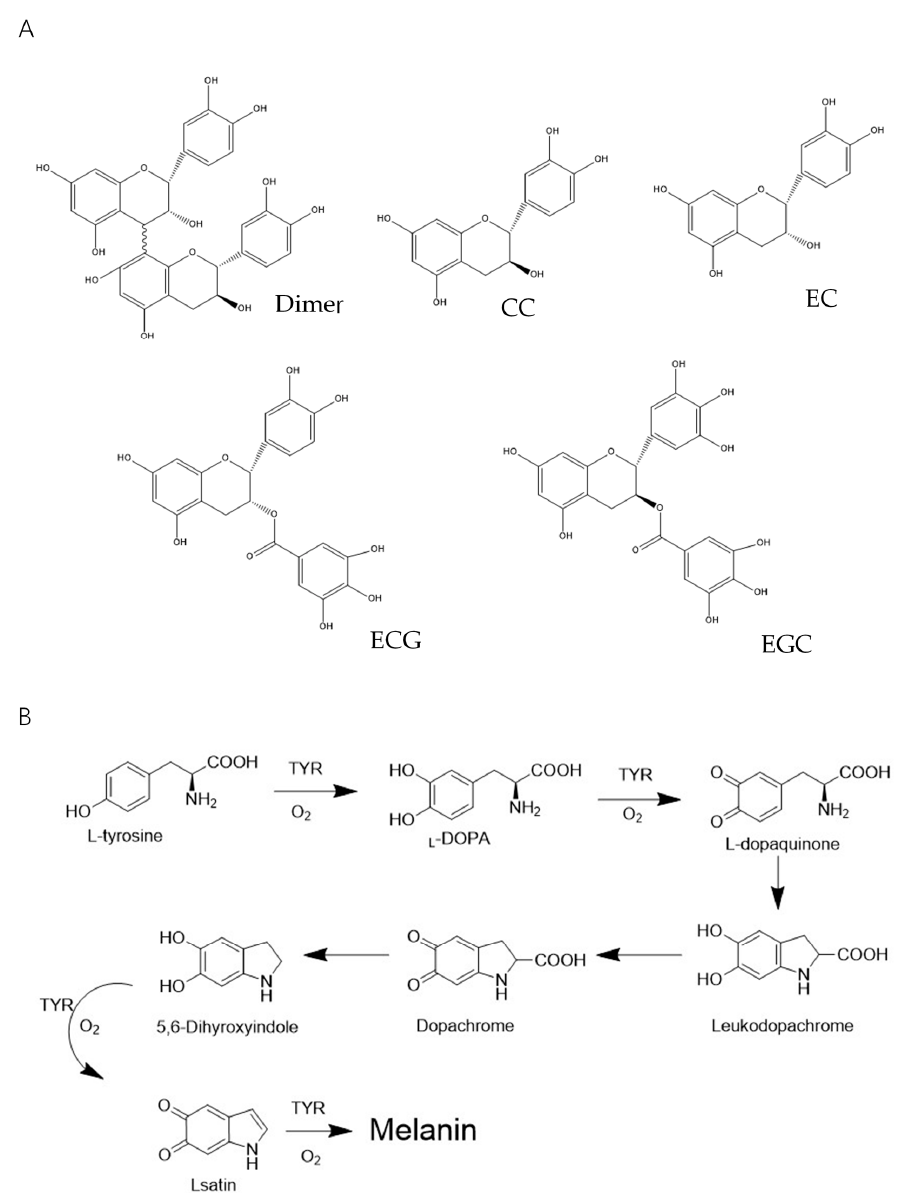
Figure 1. ( A ) The main compounds of lotus seedpod oligomeric procyanidin (LSOPC); ( B ) the key formation steps of melanin and the possible inhibition mechanism of LSOPC and LSOPC